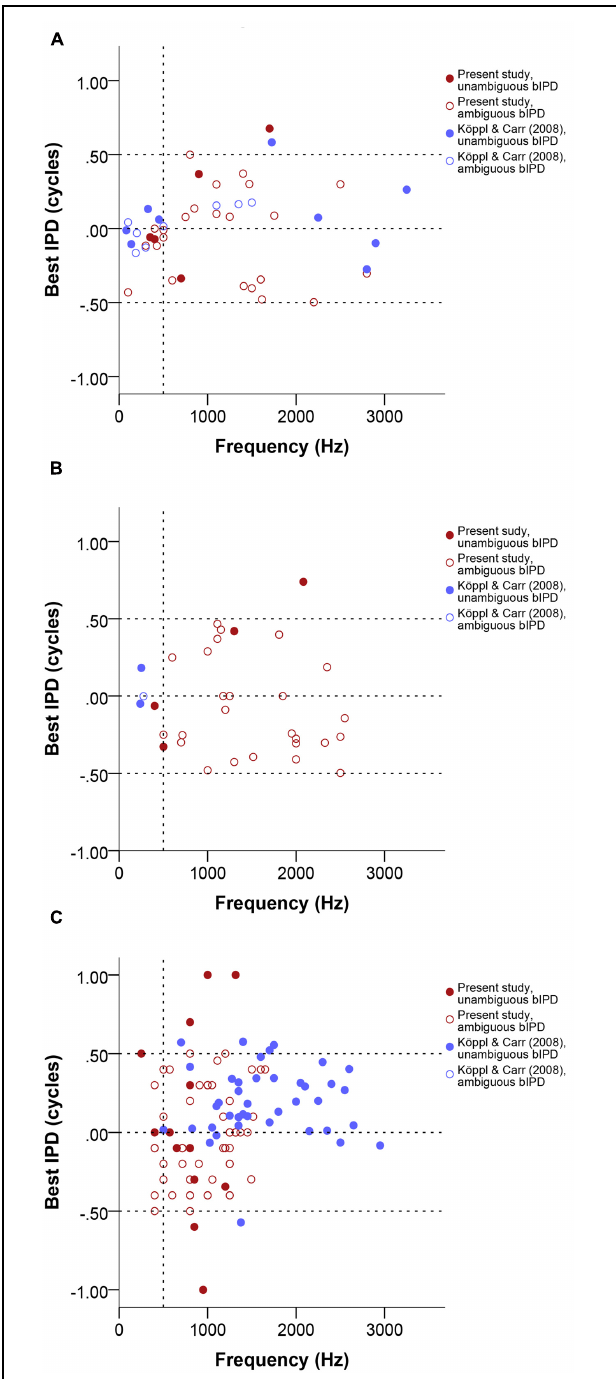
FIGURE 5 | Normalized best IPD in cycles as a function of stimulus frequency (Hz) near or at CF, separate for single units (A), multi units (B), and neurophonics (C). Red data points are data from this study, blue data points are data from Köppl and Carr (2008). Filled and open symbols represent ambiguous and unambiguous bIPDs respectively. Negative values represent ipsilateral-leading sounds and positive values represent contralateral-leading sounds. Dashed horizontal lines mark the acoustic midline at 0 µ s ITD and the pi limit at ± 0.5 cycles. A vertical dashed line marks the 500 Hz position..